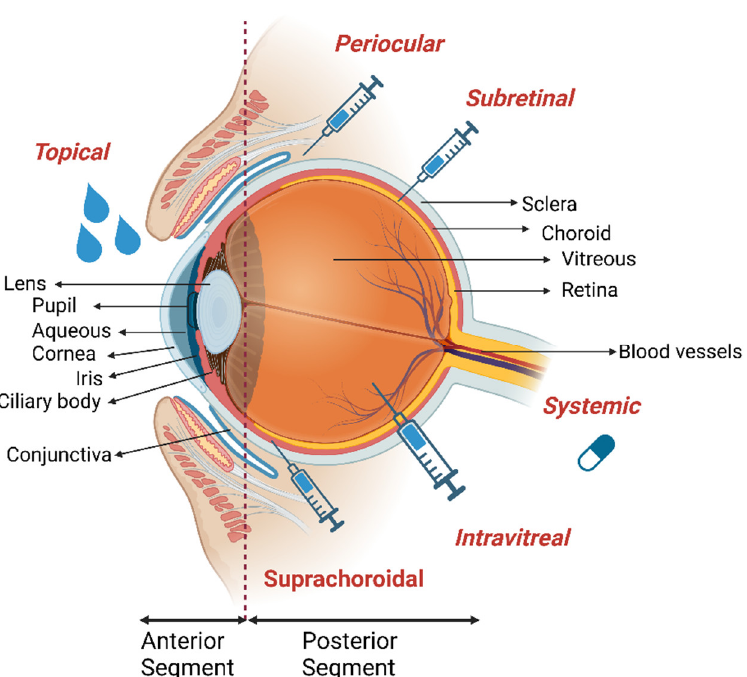
Figure 1. Anatomy of the eye. Anterior and posterior of the eye is given with the major corresponding tissues labeled. Main drug administration routes to the eye including topical, suprachoroidal, intravitreal, subretinal, periocular and systemic delivery are shown. Illustrations were created by using Biorender with agreement #GX24VQ4UJ2.